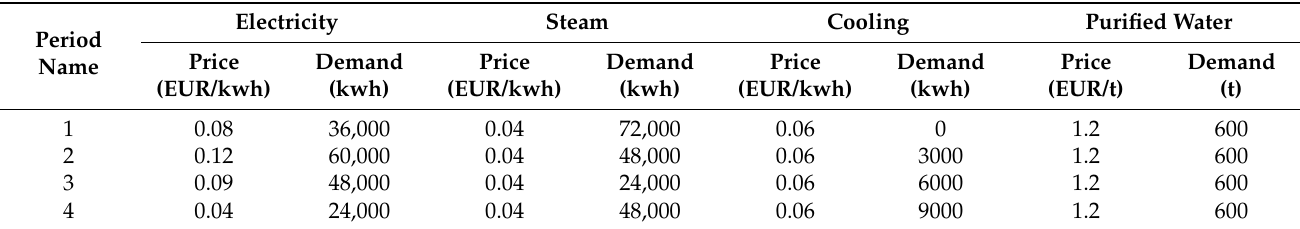
Table 1. Parameters of price and demand for materials involved in the illustrative example with four periods.